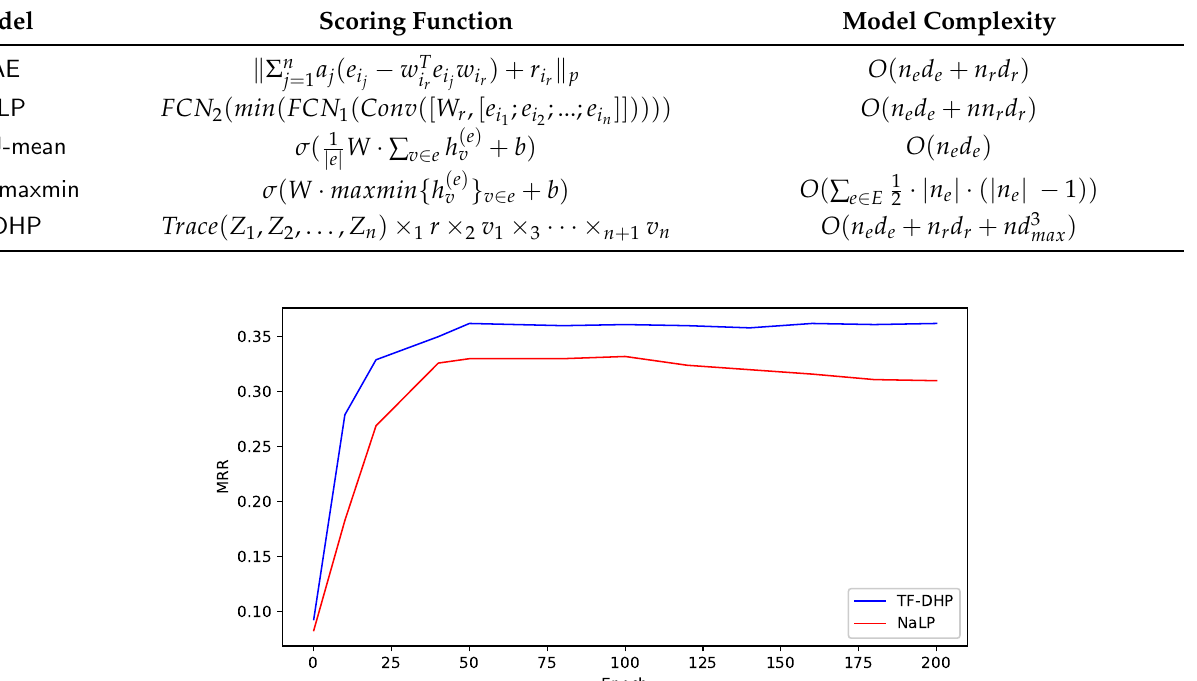
Table 2. Scoring functions of several models for undirected hypergraph link prediction tasks, with the significant terms of their model complexity. n e and n r are the number of entities and relations, while d e and d r are the dimensionalities of entity and relation embeddings respectively. n is the number of entities in a hyperlink and d max is the maximum size of TR latent tensors. maxmin is the element-wise difference of maximum and the minimum values of the vectors.